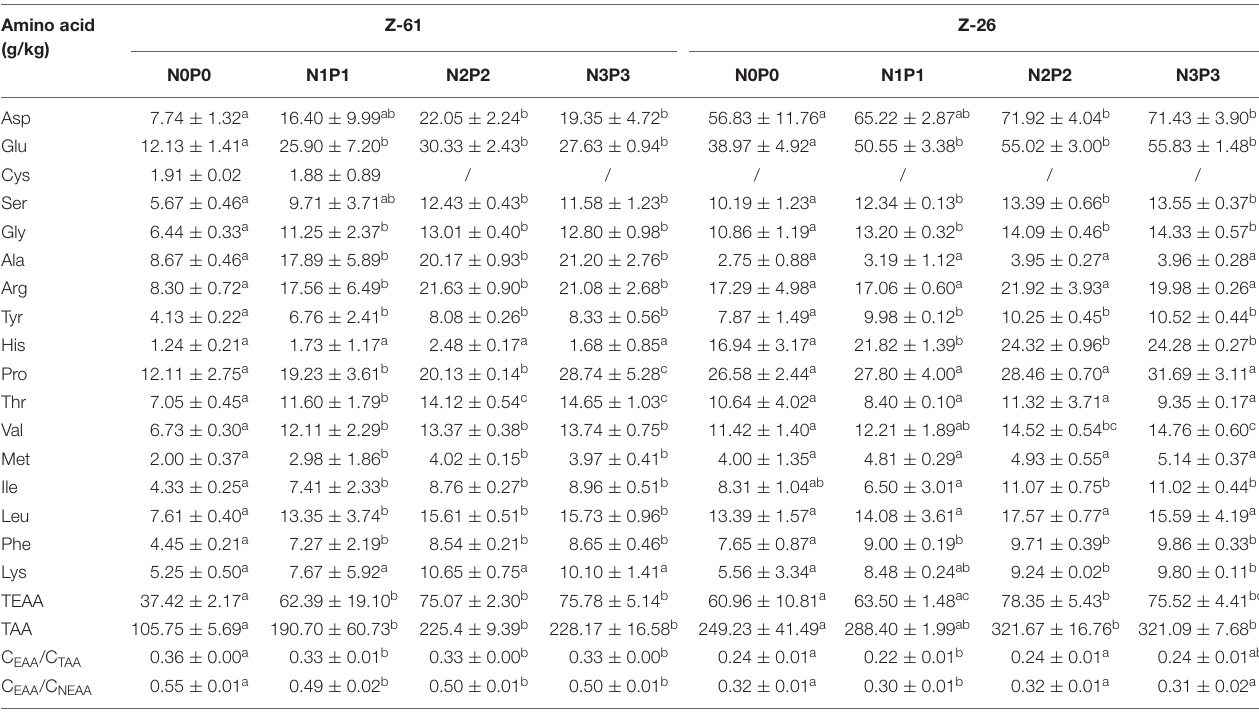
TABLE 2 | Amino acid contents (g · kg − 1 dry weight) in thalli of Z-61 and Z-26 cultured under different nutrient levels. Amino acid (g/kg)